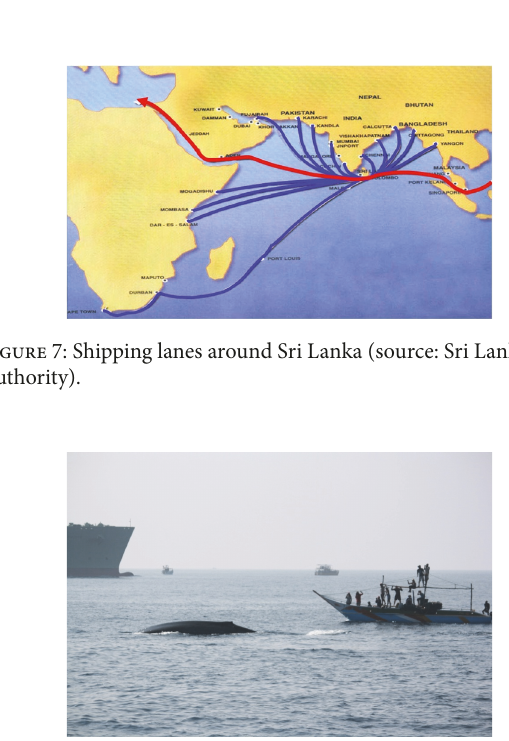
Figure 8: A blue whale off Mirissa, southern Sri Lanka, surrounded by boats and